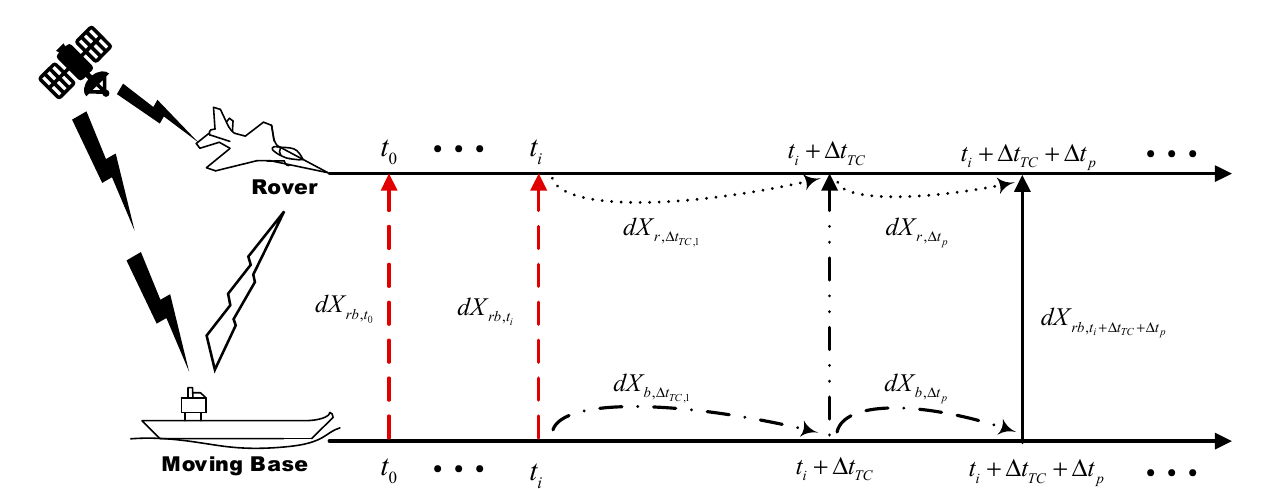
Figure 2. Integration mechanism of synchronous relative position. The RTK DGNSS relative positioning solutions and position increments of the rover and moving base are saved in a buffer to allow the integration of synchronous relative position. Assuming that RTK DGNSS relative positioning succeeds, the integration of synchronous relative position, as in Equation (13), can occur. As the position increments of the moving base can be predicted by the polynomial prediction algorithm during data outages from the rover system, the synchronous relative position can be integrated using Equation (13) at an ultra-high rate, i.e., the same as the output rate of the TC-GNSS/INS integration algorithm of the rover.